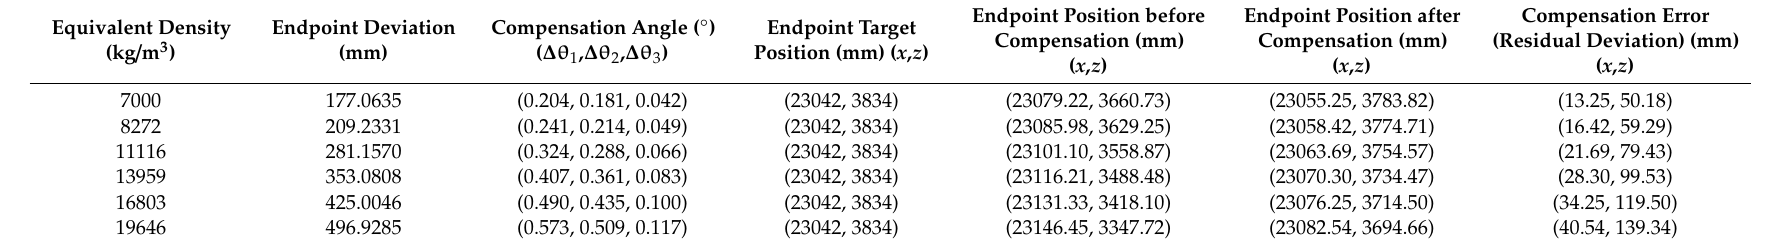
Table 3. Deformation compensation e ff ect of di ff erent equivalent